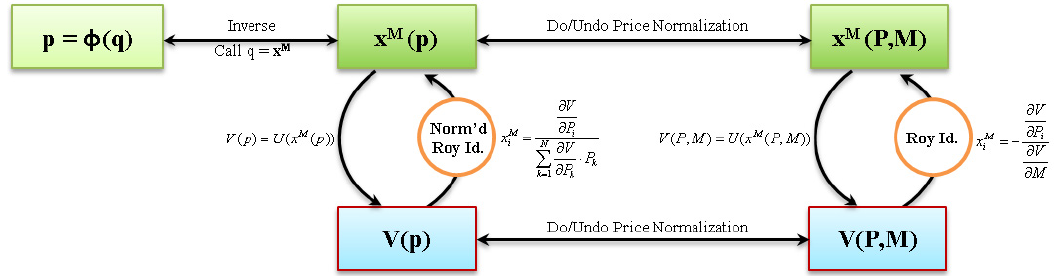
Figure 2. A more detailed version of the lower-left portion of the Wheel of Duality in the utility maximization problem. Adopted from Moosavian (2016) [10].